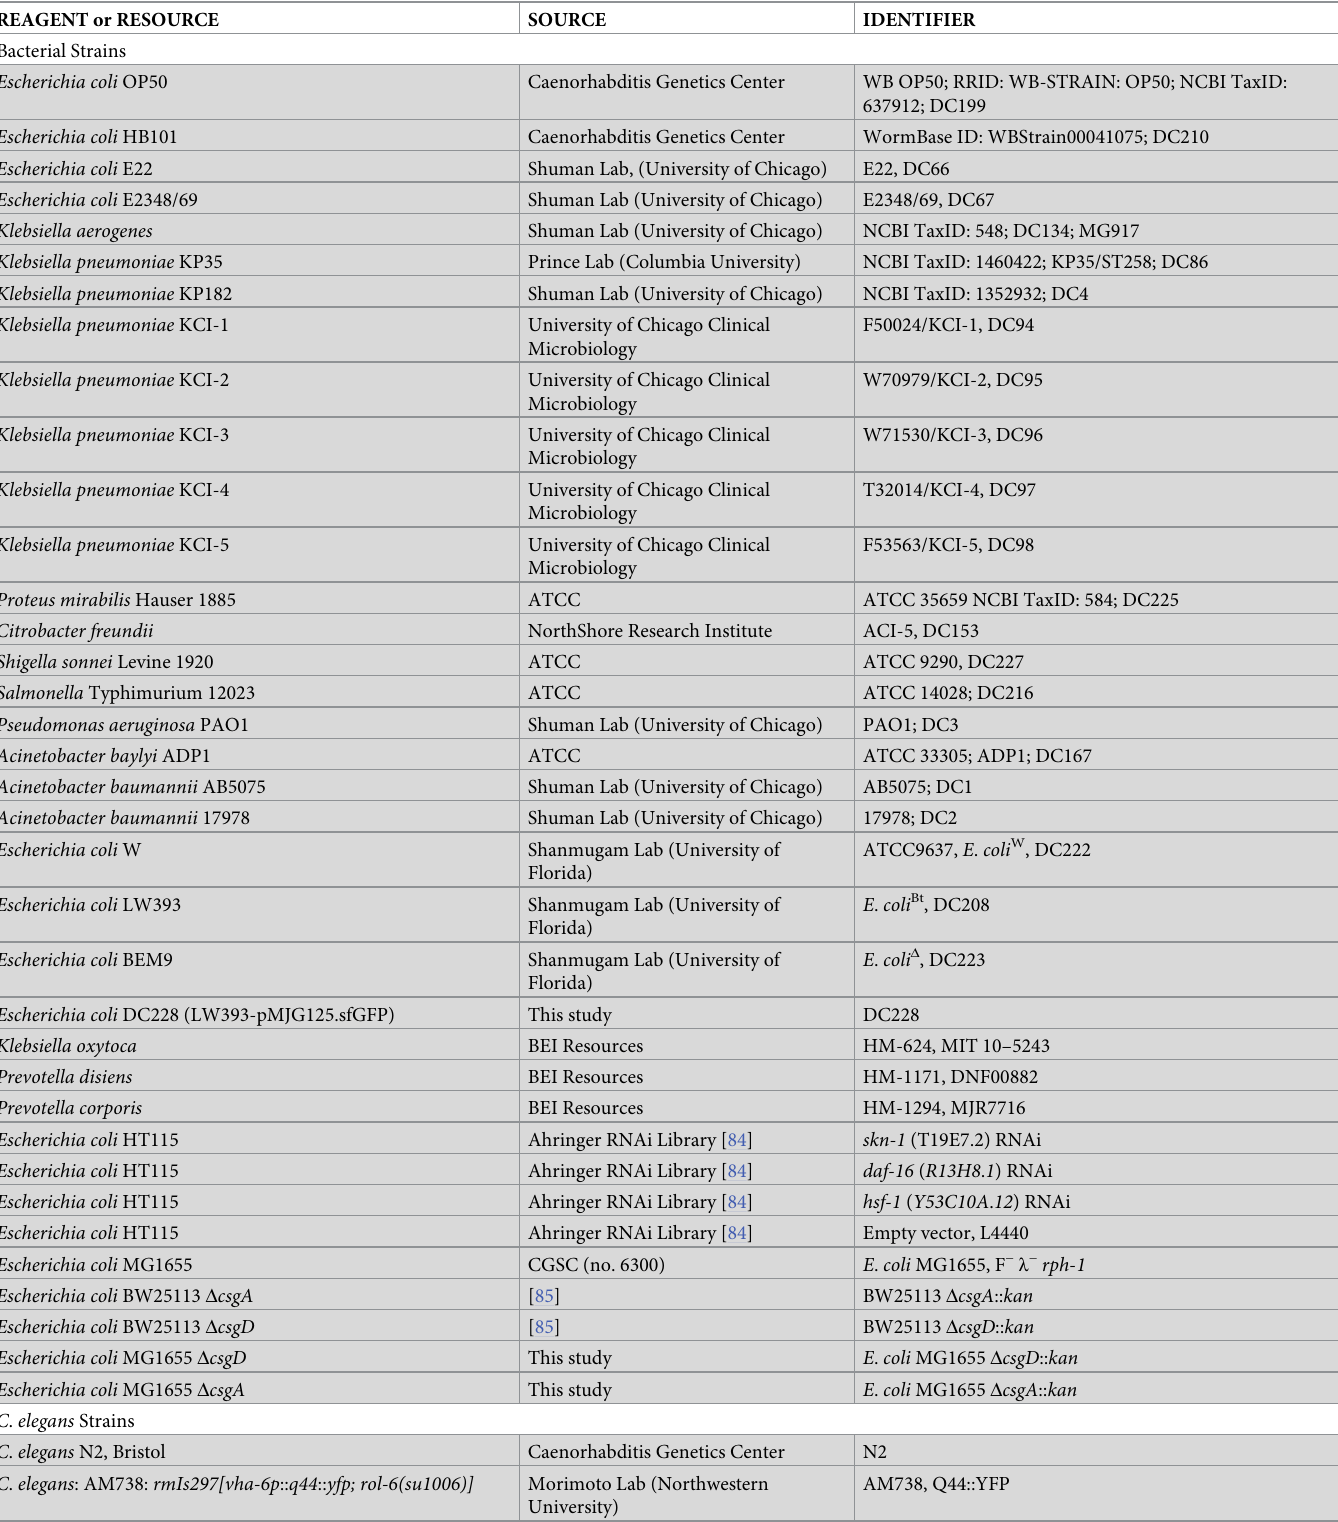
Table 1. Reagents and resources used in this study and their associated sources and